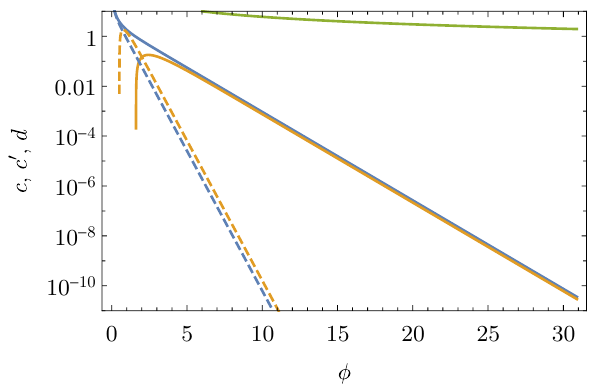
Figure 2. The maximum values of the parameters c (blue), c 0 (orange, decreasing in the left side), and d (green, the top) in the Swampland inequalities for the potential (3.1). The solid and dashed lines correspond to (cid:11) = 1 and 0 : 1, respectively. The upper bound on d does not depend on (cid:11) , and those on c and c 0 do not depend on V 0 , which is set to be 2 : 0 (cid:2) 10 (cid:0) 9